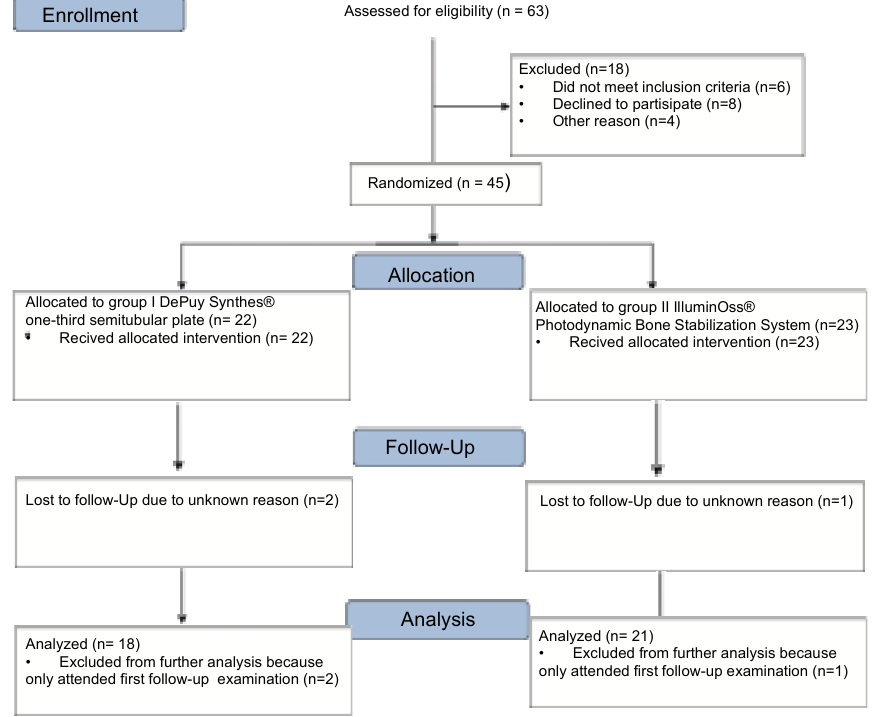
Figure 1. CONSORT (Consolidated Standards of Reporting Trials) flow diagram.